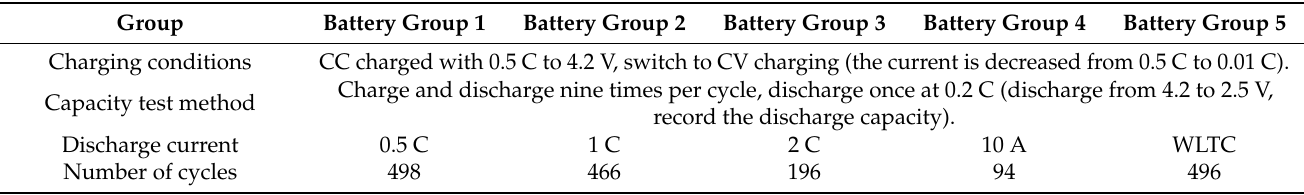
Table 2. The key parameters of the experimental